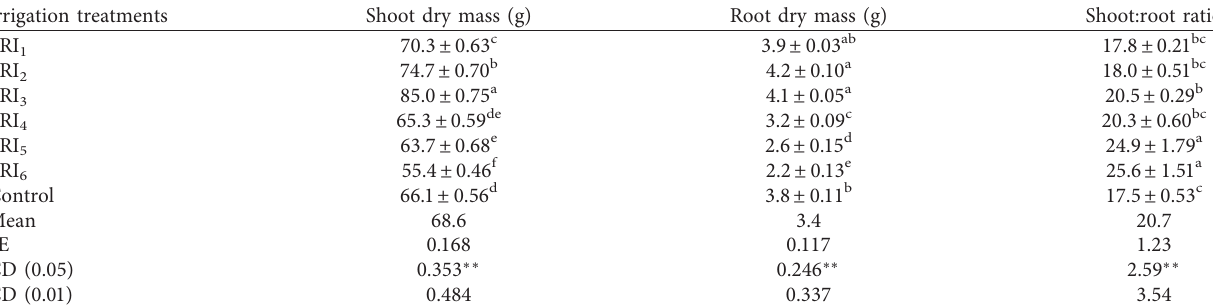
Table 4: Ratio of the shoot to root, shoot, and root dry of PMK ( R ) 3 rice by split root experiment.